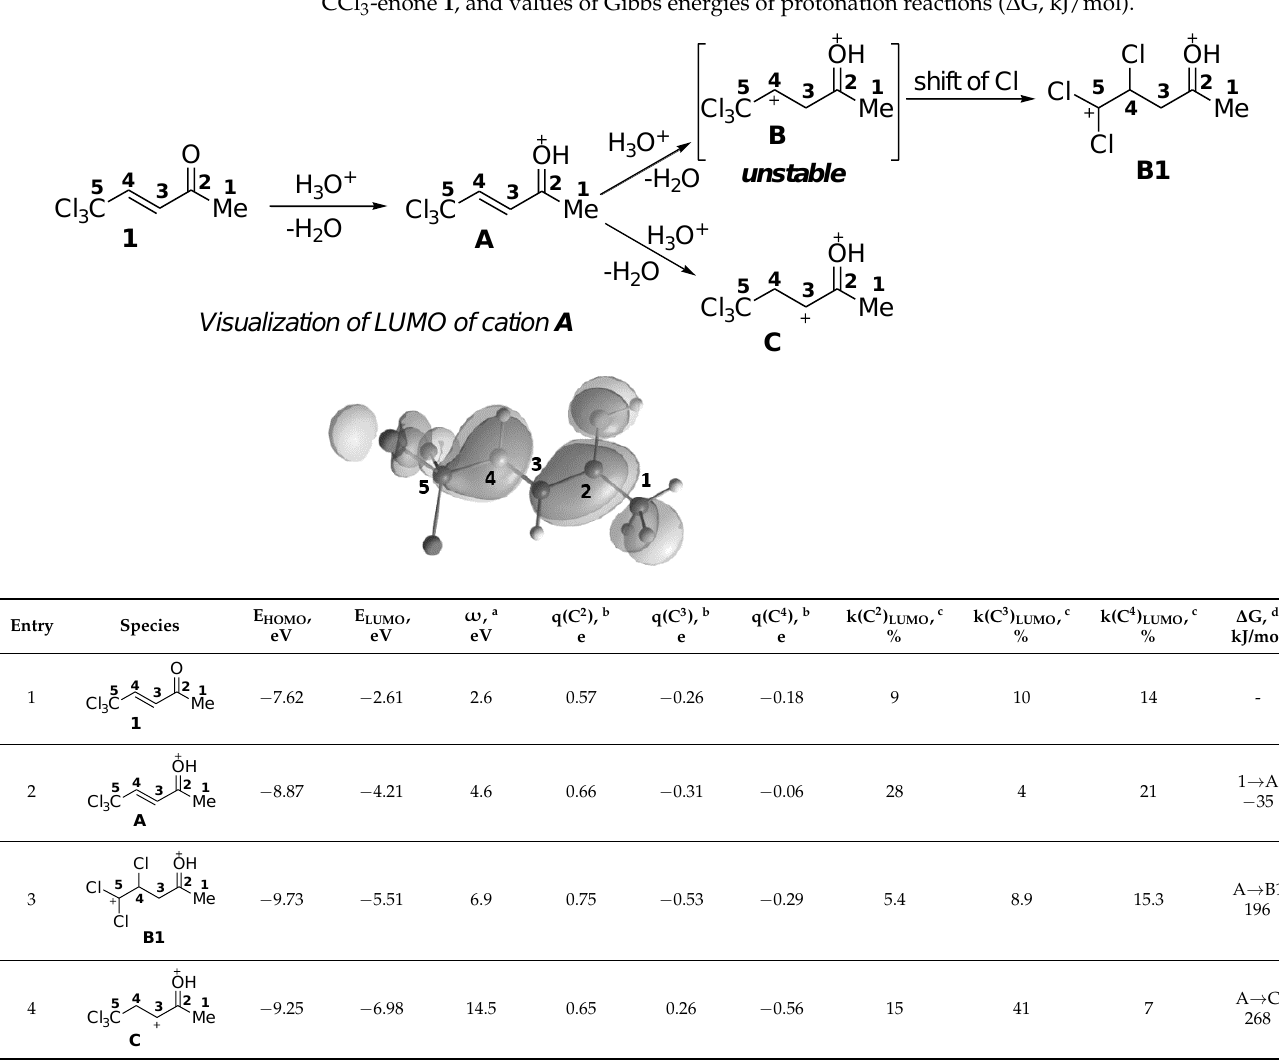
Table 2. Selected calculated (DFT) electronic characteristics of the protonated forms A , B , C of CCl 3 -enone 1 ,and values of Gibbs energies of protonation reactions (ΔG, kJ/mol).